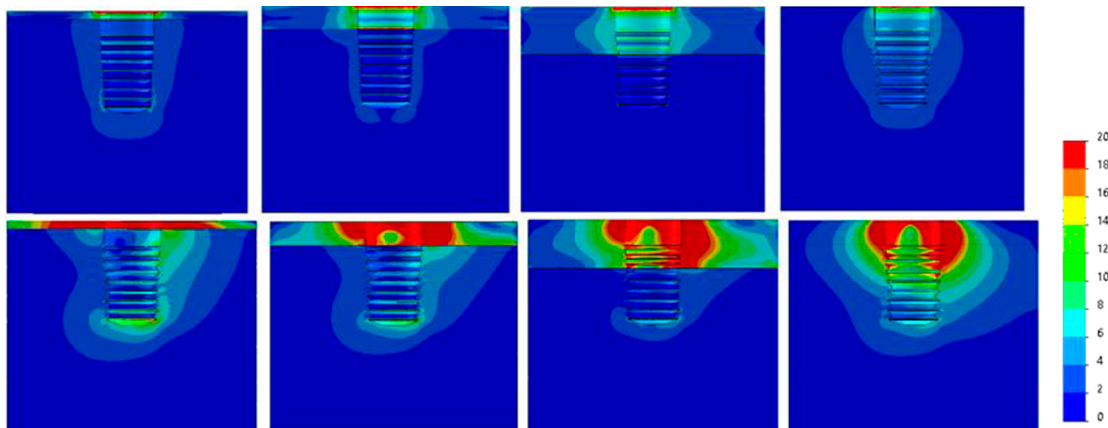
Figure 6. Maximum values of equivalent Von Mises stress (MPa) in bone tissue for each of the study scenarios under a 30° angled load of 200N. Bone type 0- I (yellow), bone type II (grey), bone type III (orange) and bone type IV (blue).